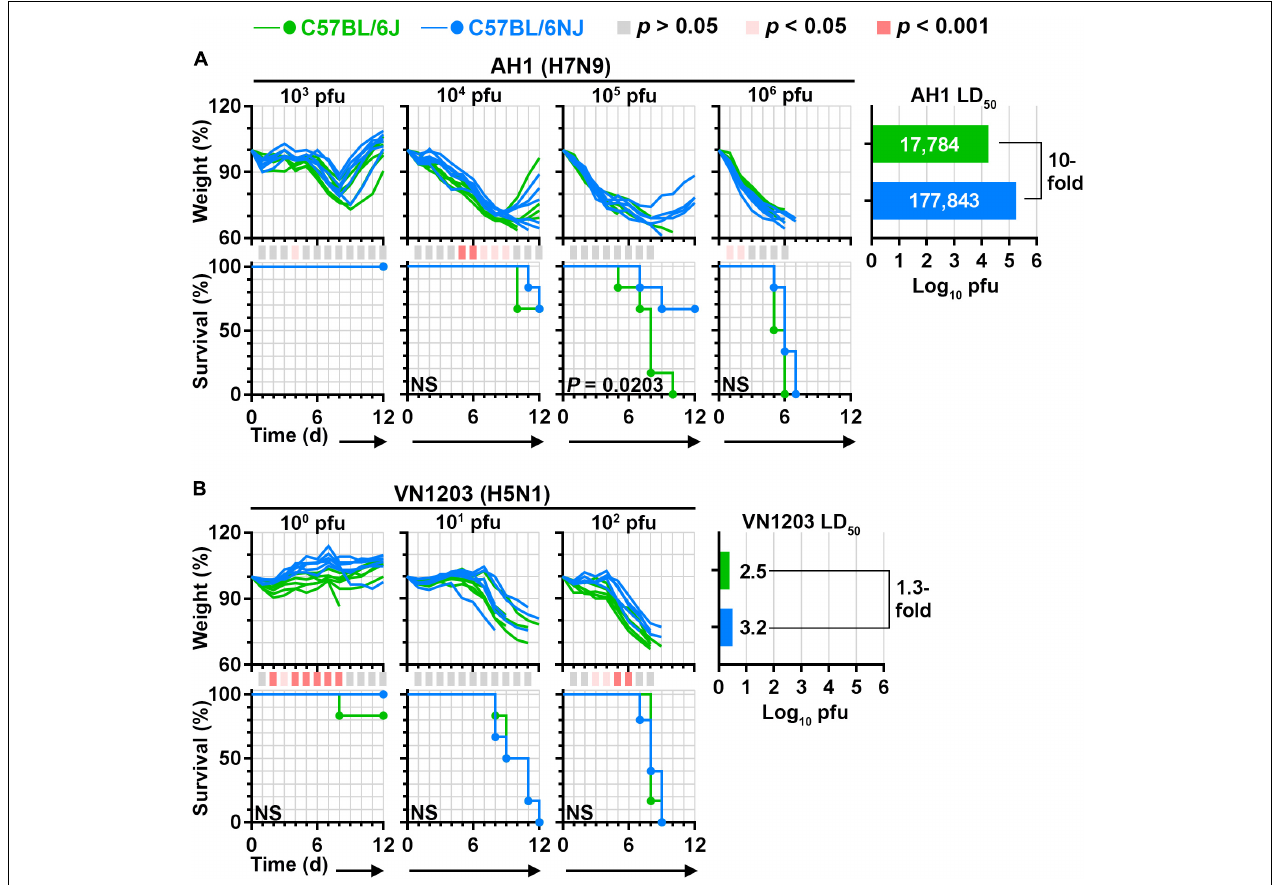
FIGURE 2 | C57BL/6J and C57BL/6NJ mice exhibit differential susceptibility to H7N9 and highly pathogenic H5N1 influenza virus disease. Groups of five or six C57BL/6J or C57BL/6NJ mice were intranasally infected with serial dilutions of (A) influenza A/Anhui/1/2013 (H7N9; ‘AH1’), or (B) influenza A/Vietnam/1203/2004 (H5N1; ‘VN1203’), and body weight ratios and survival were monitored for 12 days. Body weight ratios and significance are shown as in Figure 1B . For survival curves that significantly differ between C57BL/6J and C57BL/6NJ mice, p -values are given on the survival curve panel. Median lethal doses were calculated for each virus in each mouse strain by using the Reed and Muench method (Reed and Muench, 1938), and are shown at the right of each panel. NS, not significant; d,